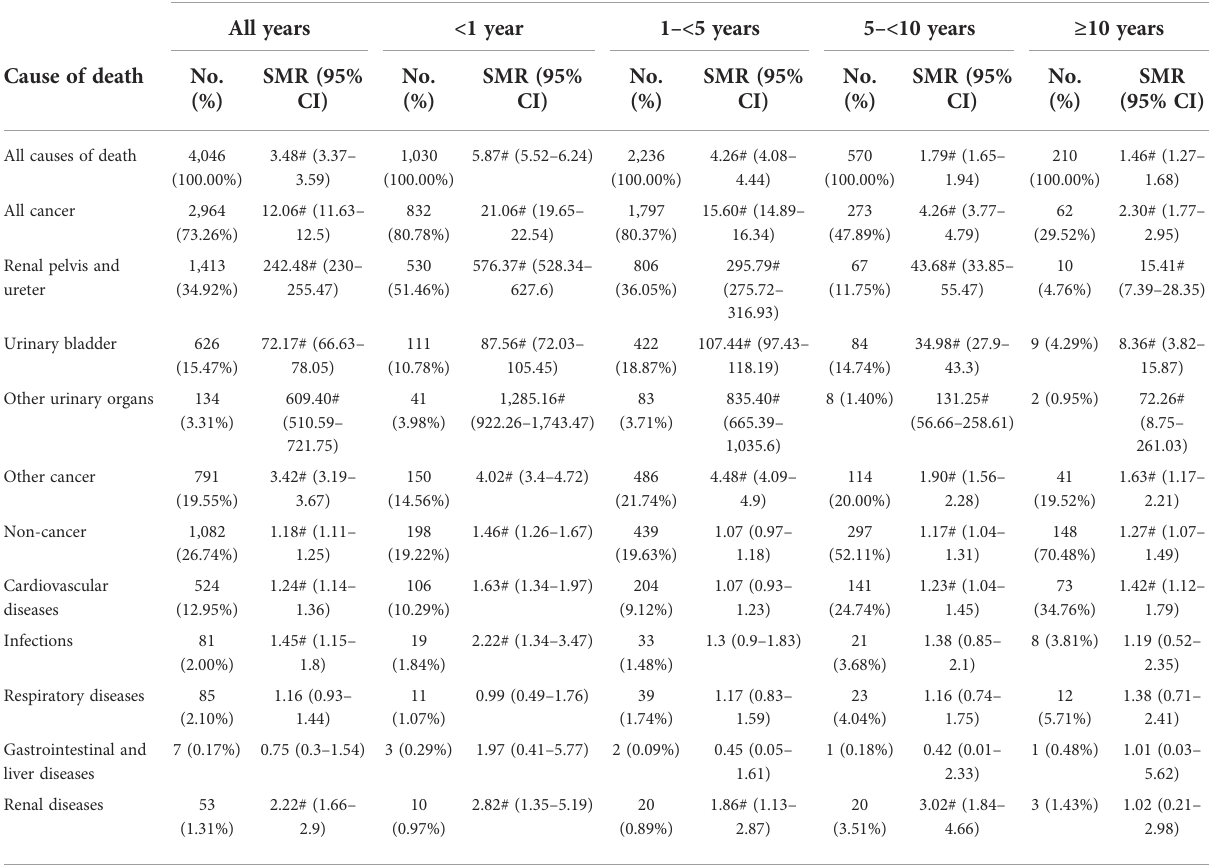
TABLE 4 Causes of death for patients with regional